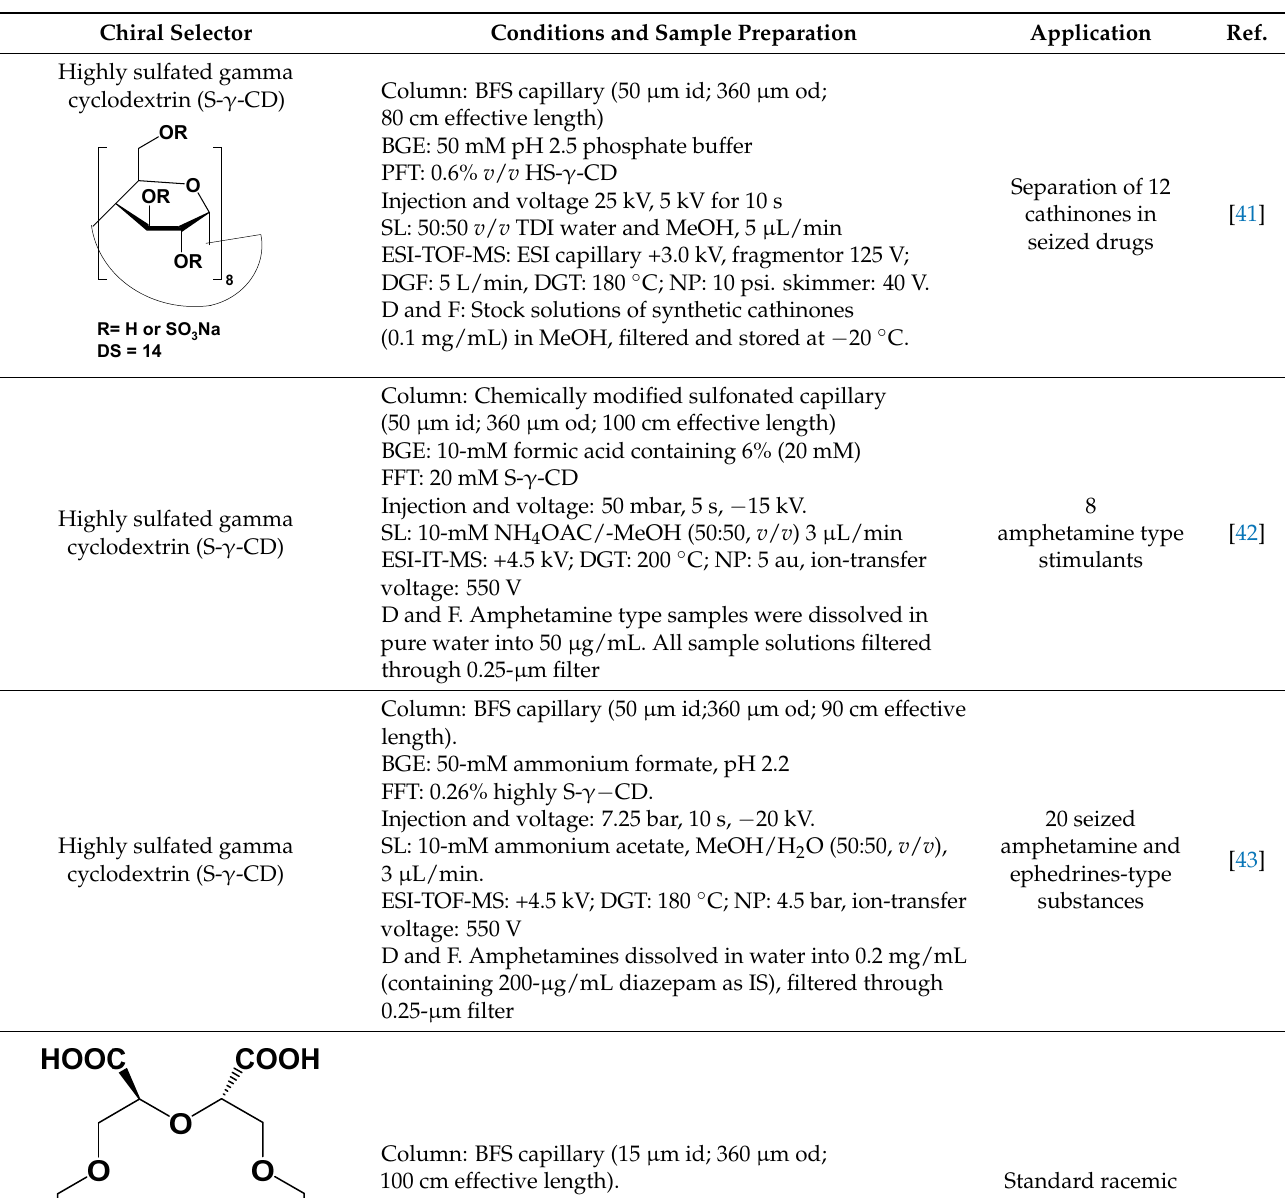
Table 1. Cont. Conditions and Sample Preparation Application